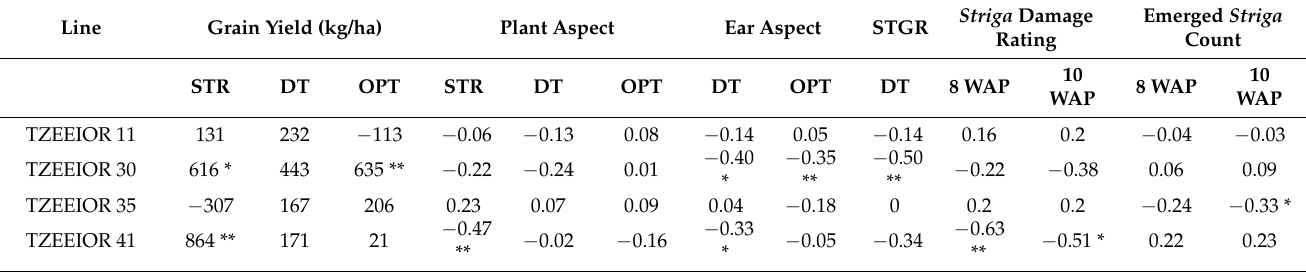
Table 5. General combining ability (GCA) effects of grain yield and other traits of 33 extra-early maturing PVA maize inbred lines and four standard inbred testers evaluated across Striga , drought, and optimum